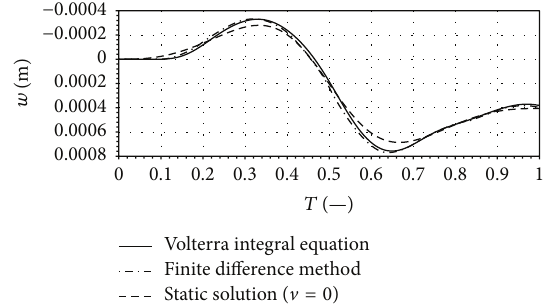
Figure 25: Dynamic deflection of point “b” (middle of the second span).